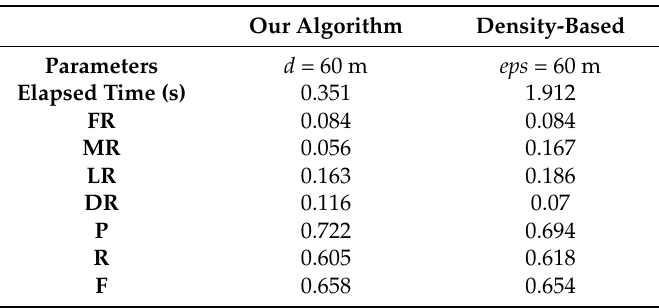
Table 4 is the comparison between our algorithm and the density-based clustering. The parameters of both the algorithms are set to 60 m. Compared with the density-based method, our